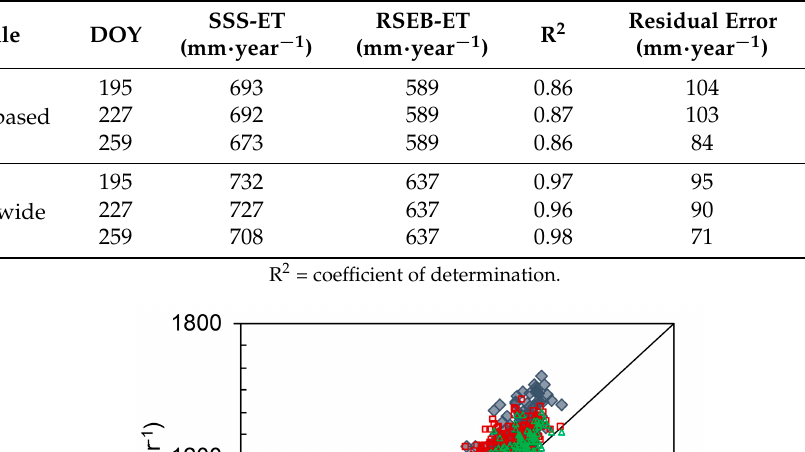
Table 1. Summary of pixel-based and area-wide comparison of SSS-ET and RSEB-ET.